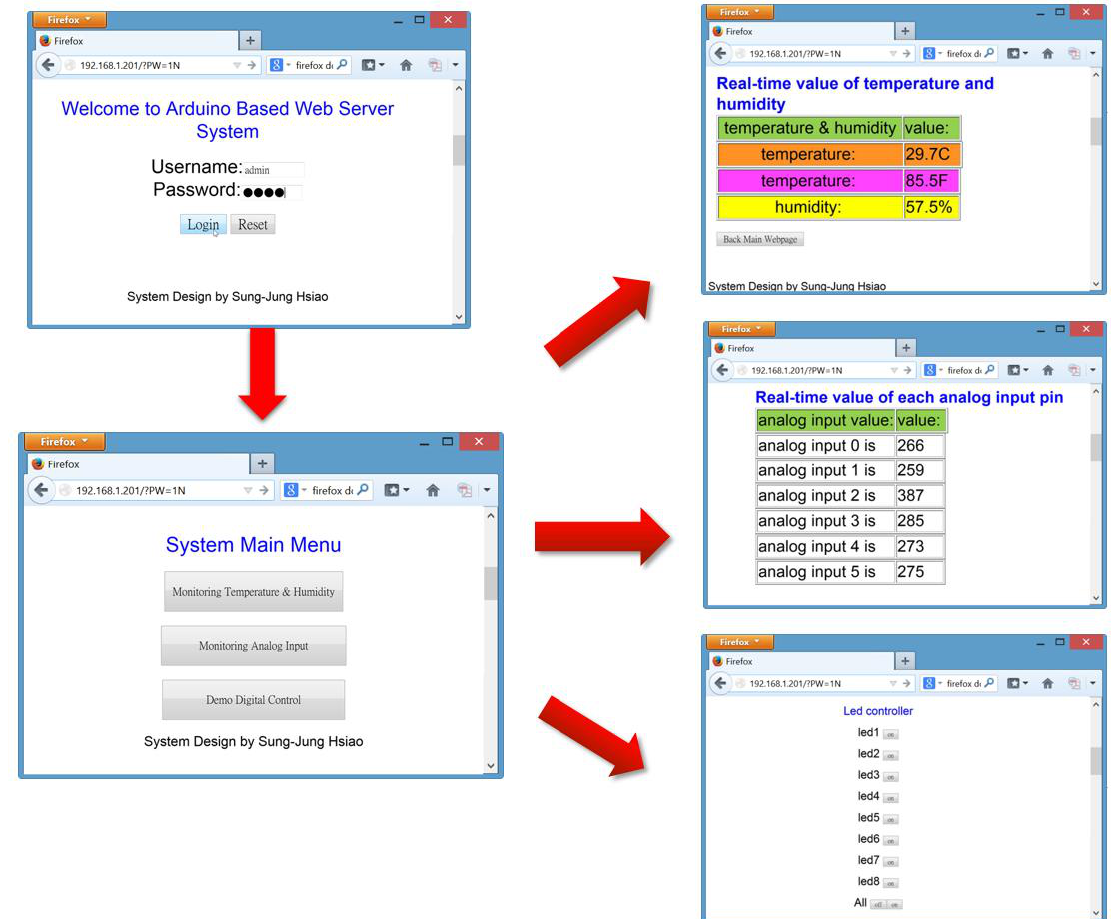
Figure 40. Arduino Based Web Server (ABWS)